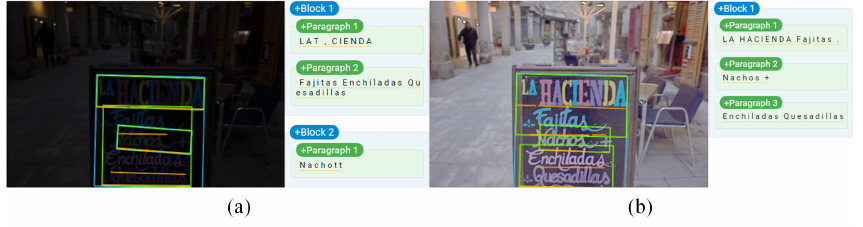
Figure 9. Results of Google Cloud Vision API. ( a ) Recognition result of low-light image; ( b ) Recogni- tion result of our enhanced